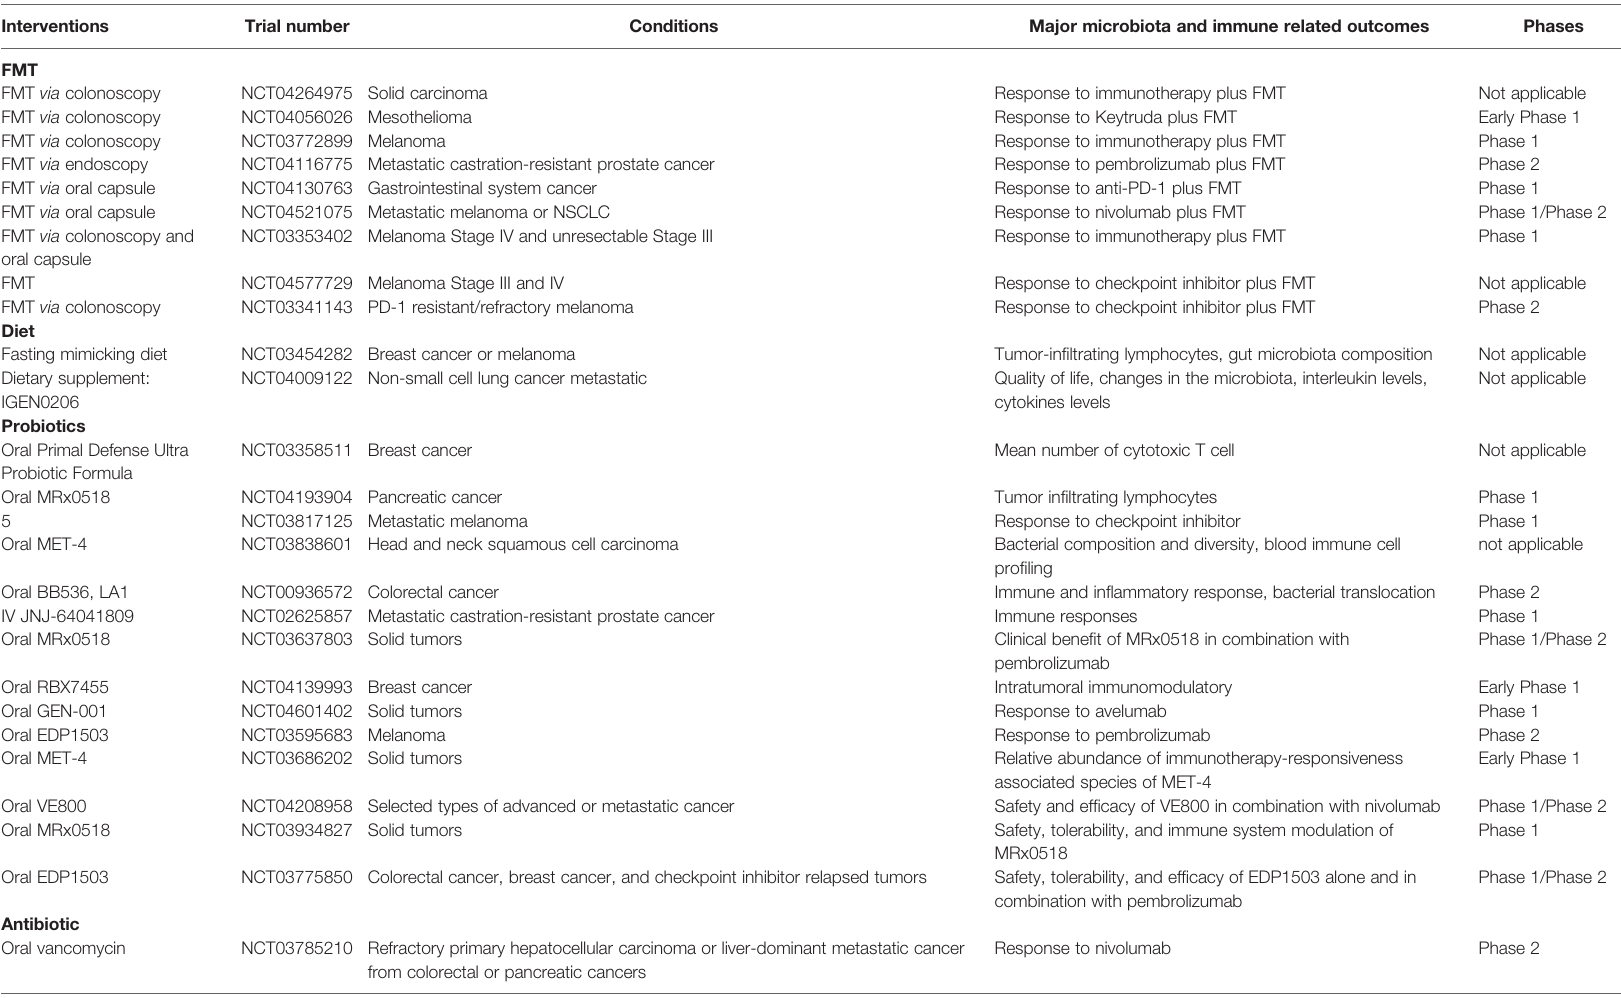
TABLE 3 | Clinical trials linking gut microbiota and cancer